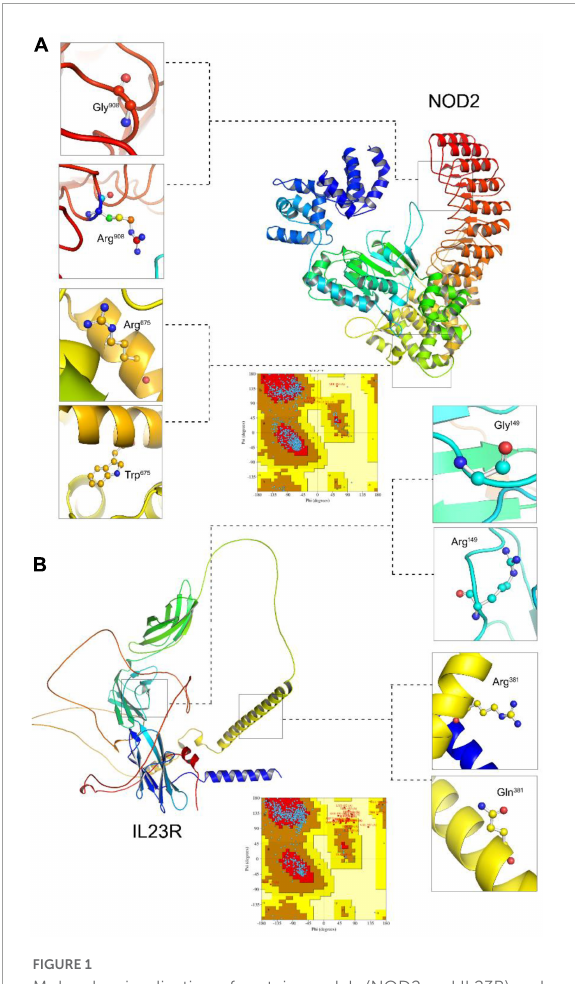
FIGURE1 Molecular visualization of protein models (NOD2 and IL23R) and Ramachandran plots. (A) The NOD2 protein structure, zoom view represent localization of Gly908 (wildtype), Arg908 (mutated). (B) The IL23R protein structure zoom view represent localization of Gly149 (wildtype), Arg149 (mutated), Arg381 (wildtype), Gln381 (mutated).